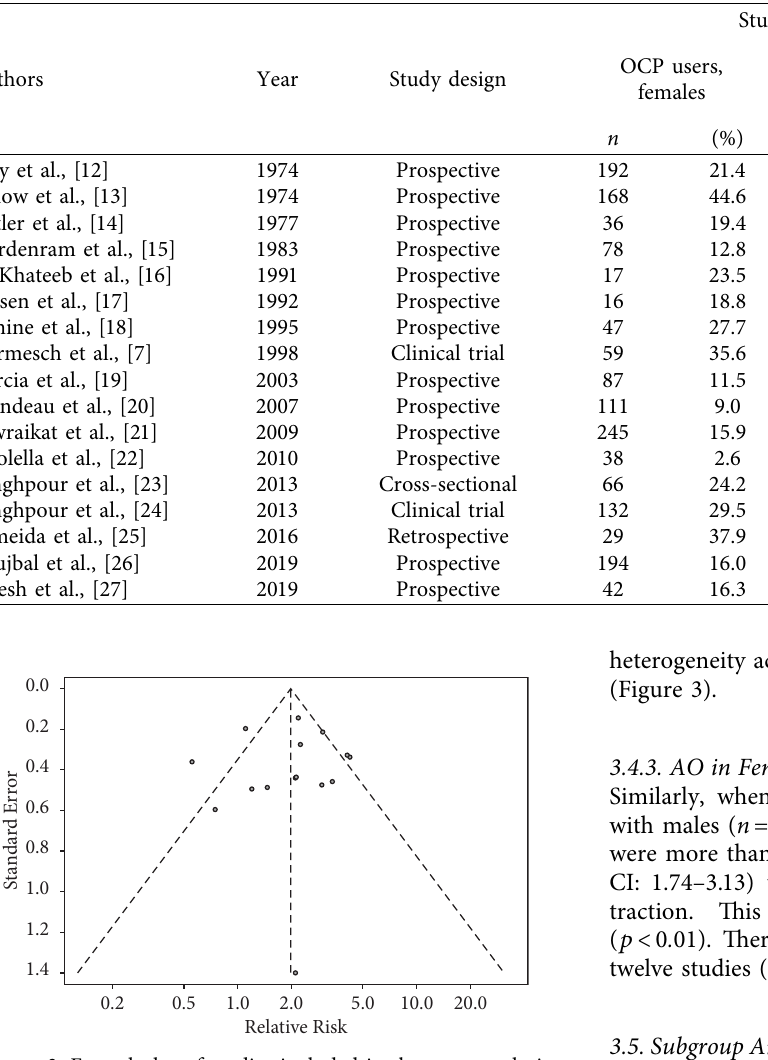
Figure 2: Funnel plot of studies included in the